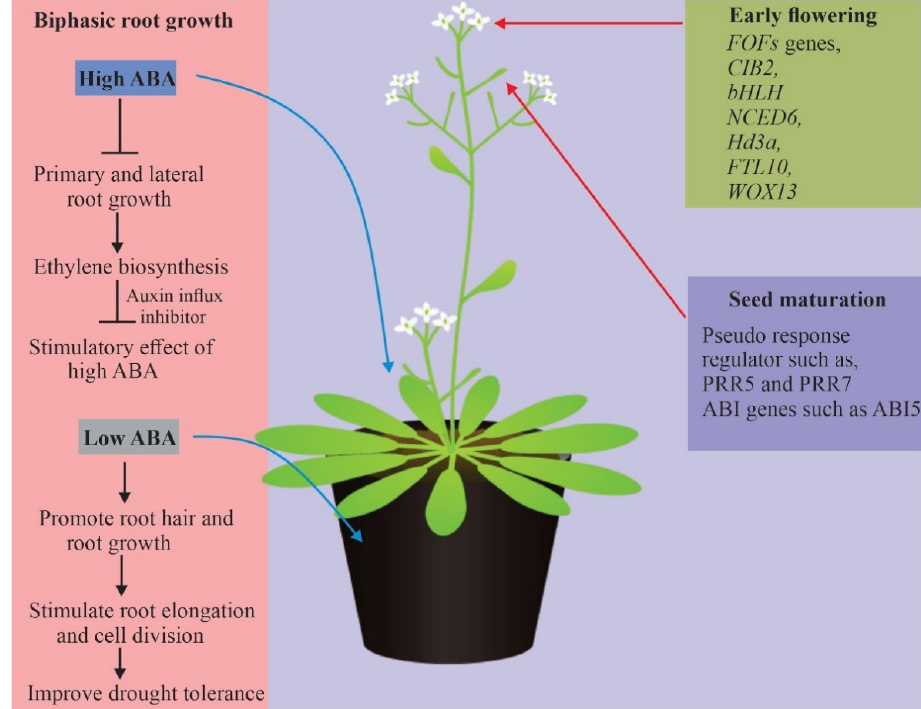
Figure 5. The molecular basis of ABA ‐ mediated plant response to drought. A high concentration of ABA imposed a negative effect on auxin influx, while a low concentration of ABA promotes root growth resulted in enhanced drought tolerance.